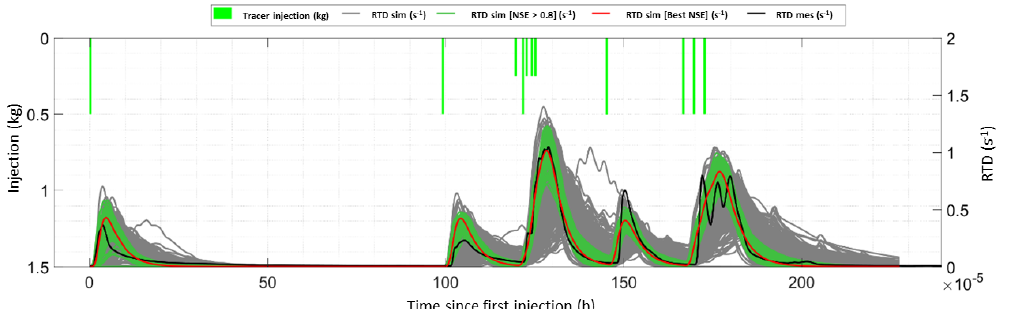
Figure 5. Tracer injection (green bars), experimental residence time distribution (RTD; black solid line) and simulated RTD curves: grey lines represent simulated RTD for all scenarios, green lines represent simulated RTD with an Nash-Sutcliff Efficiency coefficient (NSE) superior to 0.8 and the red line is the simulation providing the best NSE (0.89).